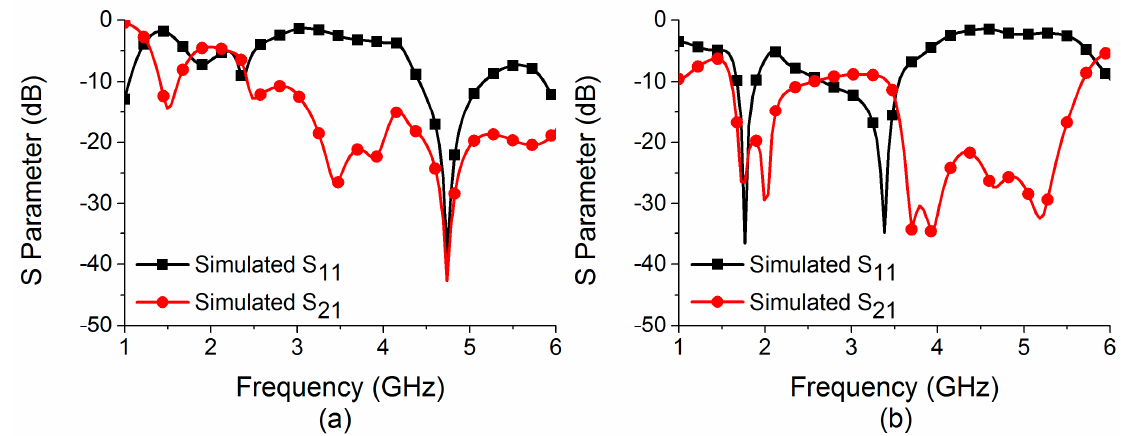
Figure 15. Simulated S-parameters of MIMO antenna in ( a ) ON state and ( b ) OFF state.